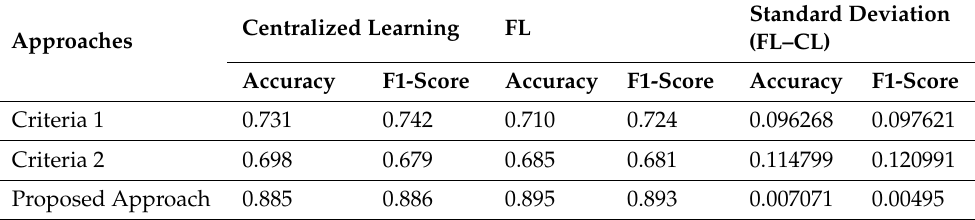
Table 7. Accuracy and F1-score assessment versus the two starting points. Baseline 2 is training data containing unrelated images, Criteria 1 (manual label) is the best scenario, where each instance is carefully tagged and evaluated when compared to Baseline 2 and Baseline 1 across both datasets. The suggested technique achieves a significant improvement in human sentiments in the disaster situation dataset context.